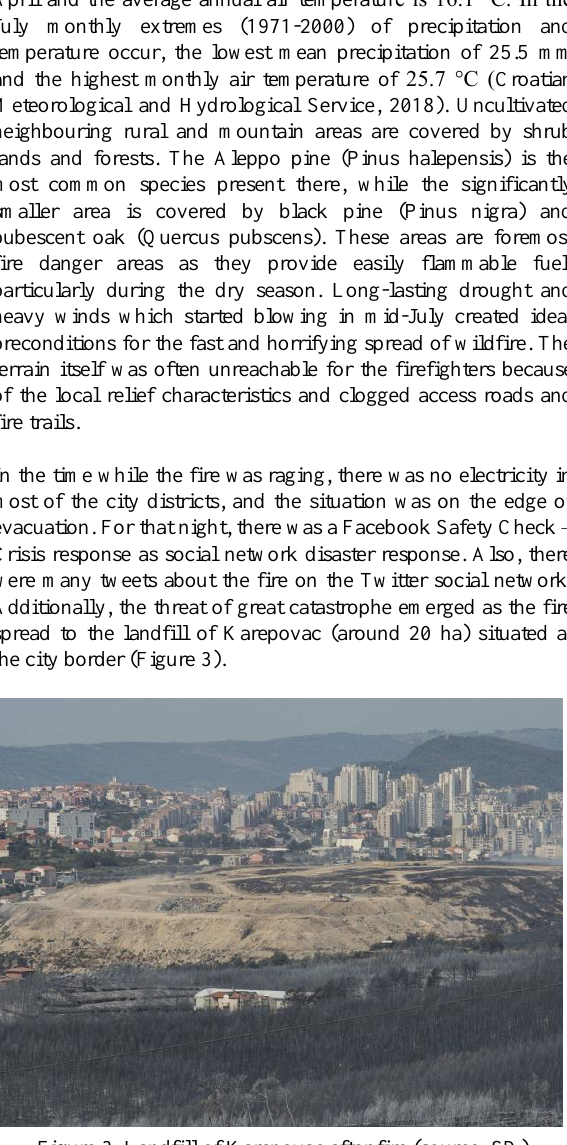
Figure 3. Landfill of Karepovac after fire (source: